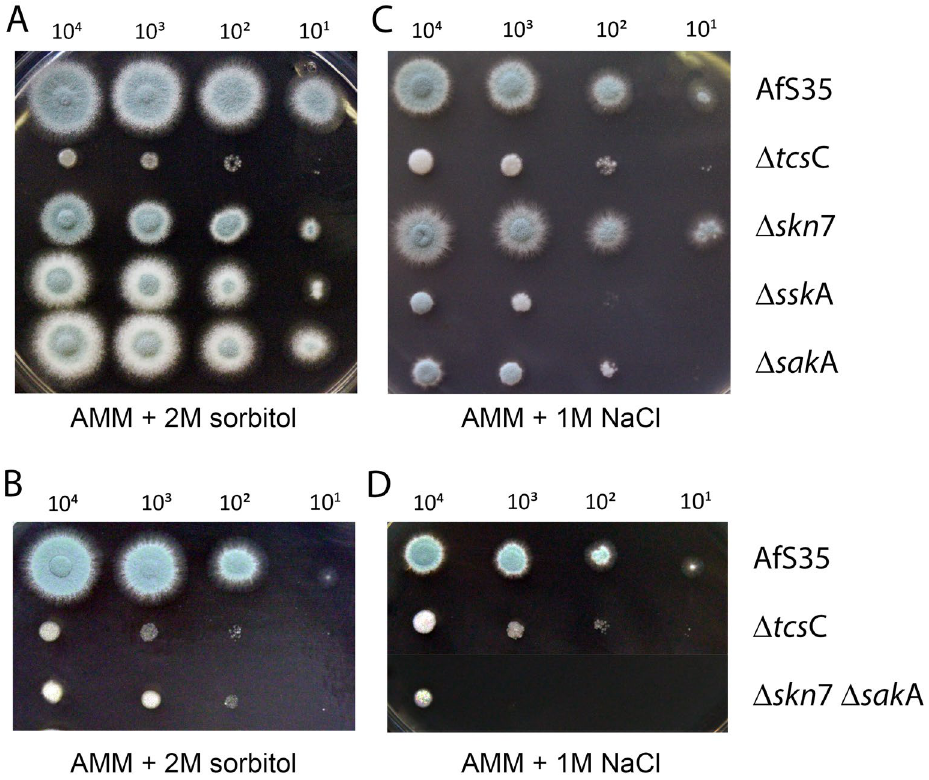
Figure 4. Impact of hyperosmotic stress on the growth of A. fumigatus HOG pathway mutants. Drop dilution assays on plates containing AMM + 2 M sorbitol (panels A and B ) and AMM + 1 M NaCl (panels C and D ). Plates were incubated at 37 °C for 72 h. The strains and the number of conidia that were applied per drop are indicated.